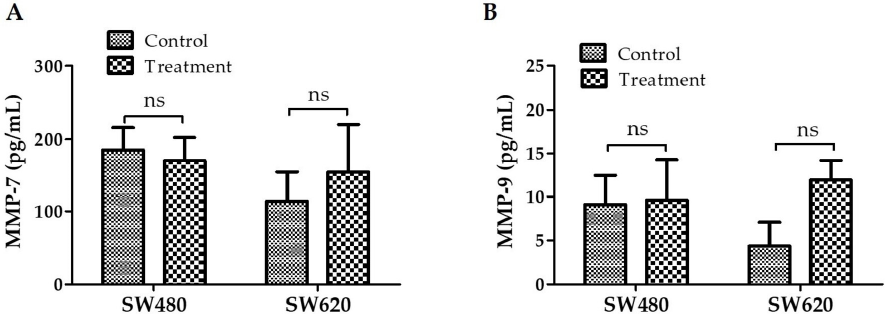
Figure 9. Effect of LMPE on MMP-7 ( A ) and MMP-9 ( B ) expression in SW480 and SW620 cell lines. Cells were exposed to 30 mg LMPE/mL for 48 h. Untreated cells (0 mg LMPE/mL) were used as a control. Data are expressed as mean ± SEM ( n = 3). The differences between the control and the treated cells were analyzed with the Student’s t test, ns = non-significant difference.